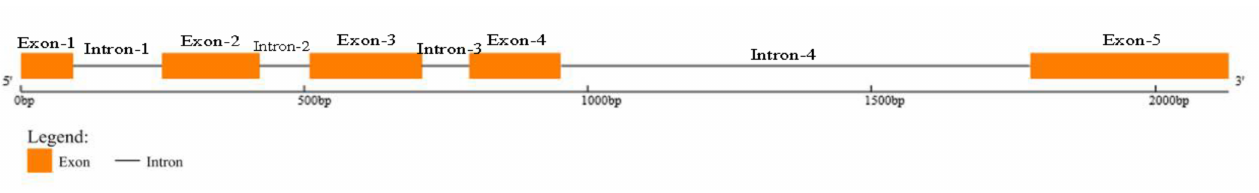
Figure 4. TBL34 gene structure diagram. Note: Information of sequence variations for each exon and intron refers to Table S3.